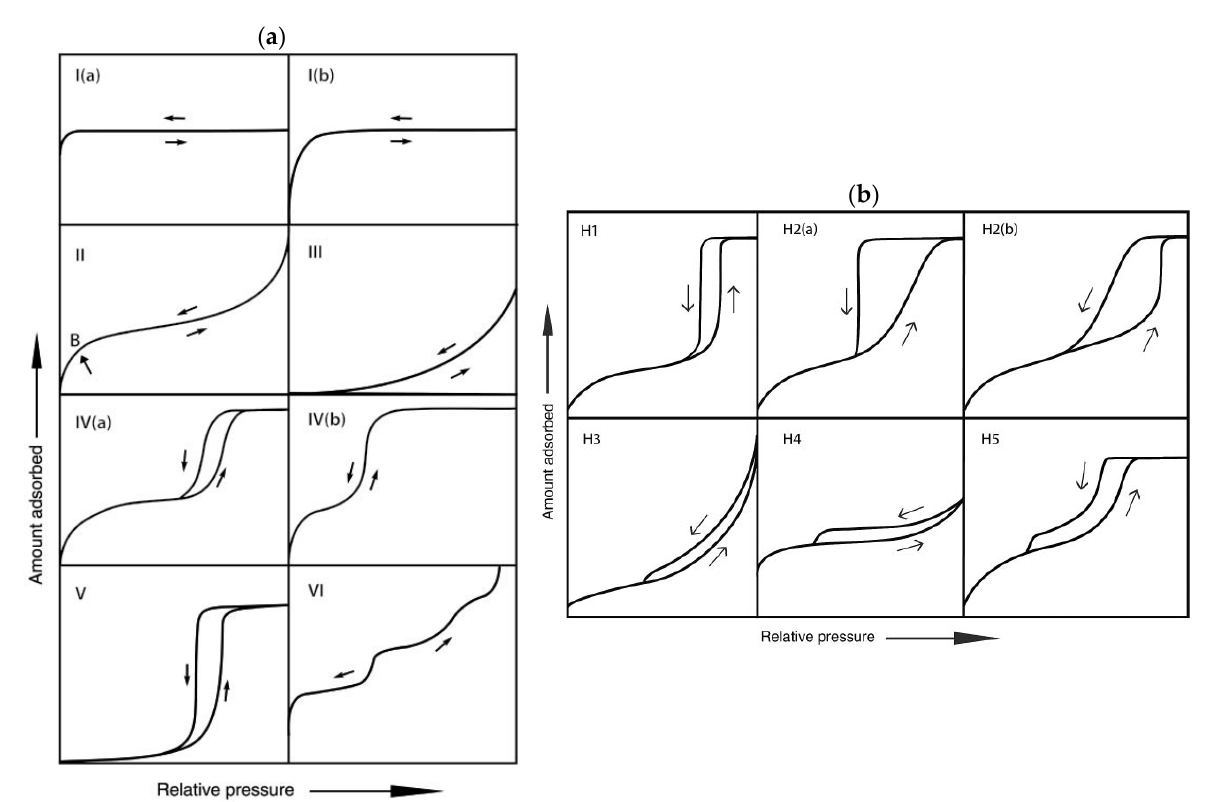
Figure 3. ( a ) The IUPAC Classification of adsorption isotherms for gas–solid equilibria. ( b ) The classification of hysteresis loops (reprinted from [9] with permission, © IUPAC, De Gruyter, 2015). Most of the adsorption isotherms obtained for highly porous aerogels are type IV.